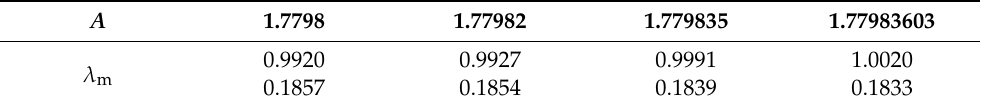
Table 1. Period-8 motion Floquet multipliers λ m around the turning point A 8